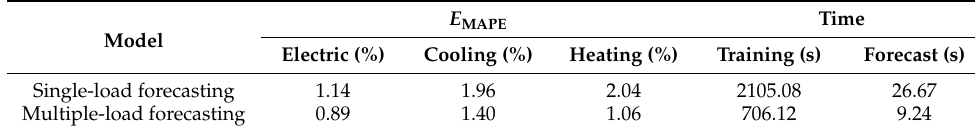
Table 6. Error comparison between single-load and multiple-load forecasting.